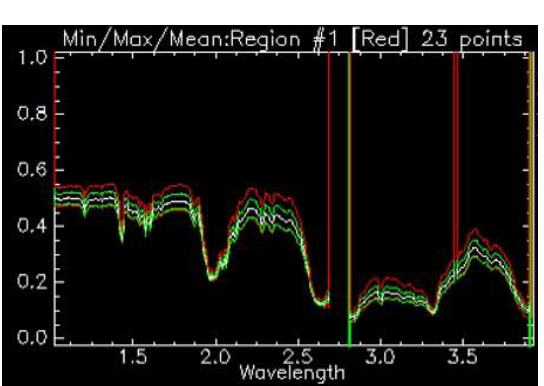
Figure 9: Maximum, minimum mean and standard deviations for the ROI in blue in figure 7